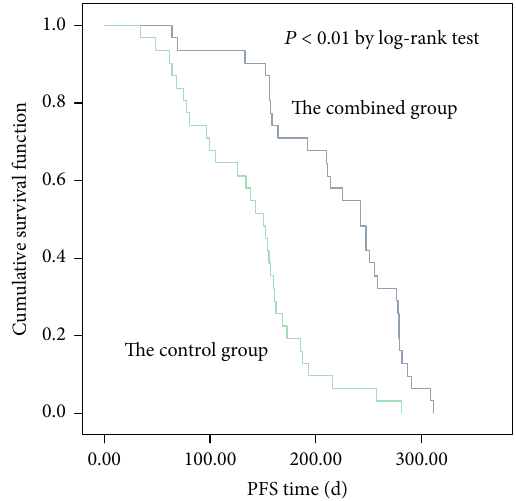
Figure 2: K-M curve for PFS time of the two groups of patients. Table 3: Quality of life and nutrition condition for all